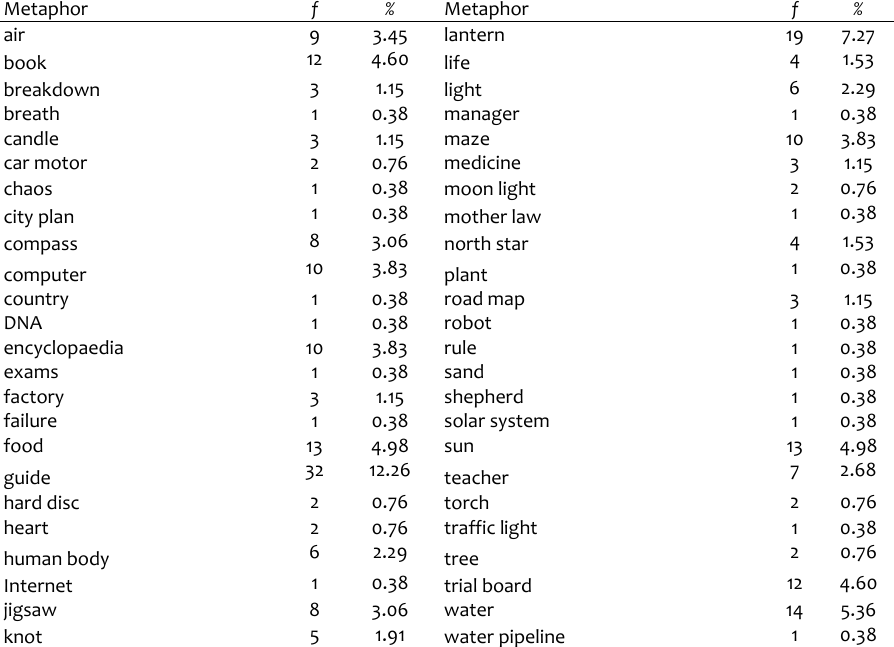
Table 1 . Frequency and percentage values regarding curriculum